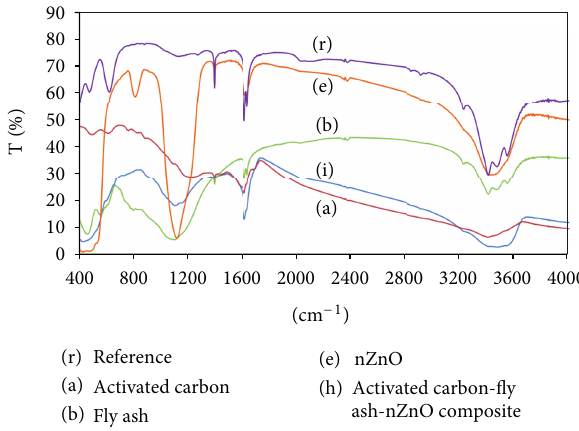
F 13: F�I� spectrum of precursors and activated carbon-�y ash-nZnO composite